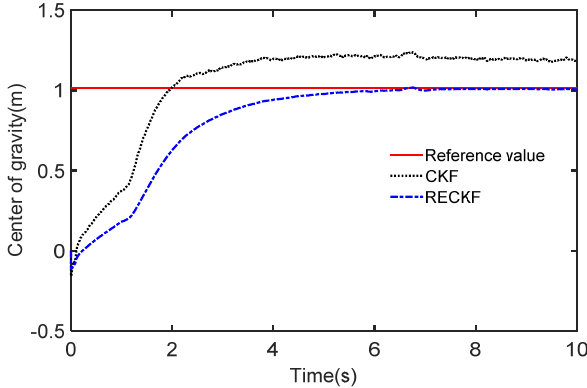
Figure 13. The estimated CG in the case of deceleration. Table 5. The RMSE in the case of deceleration.